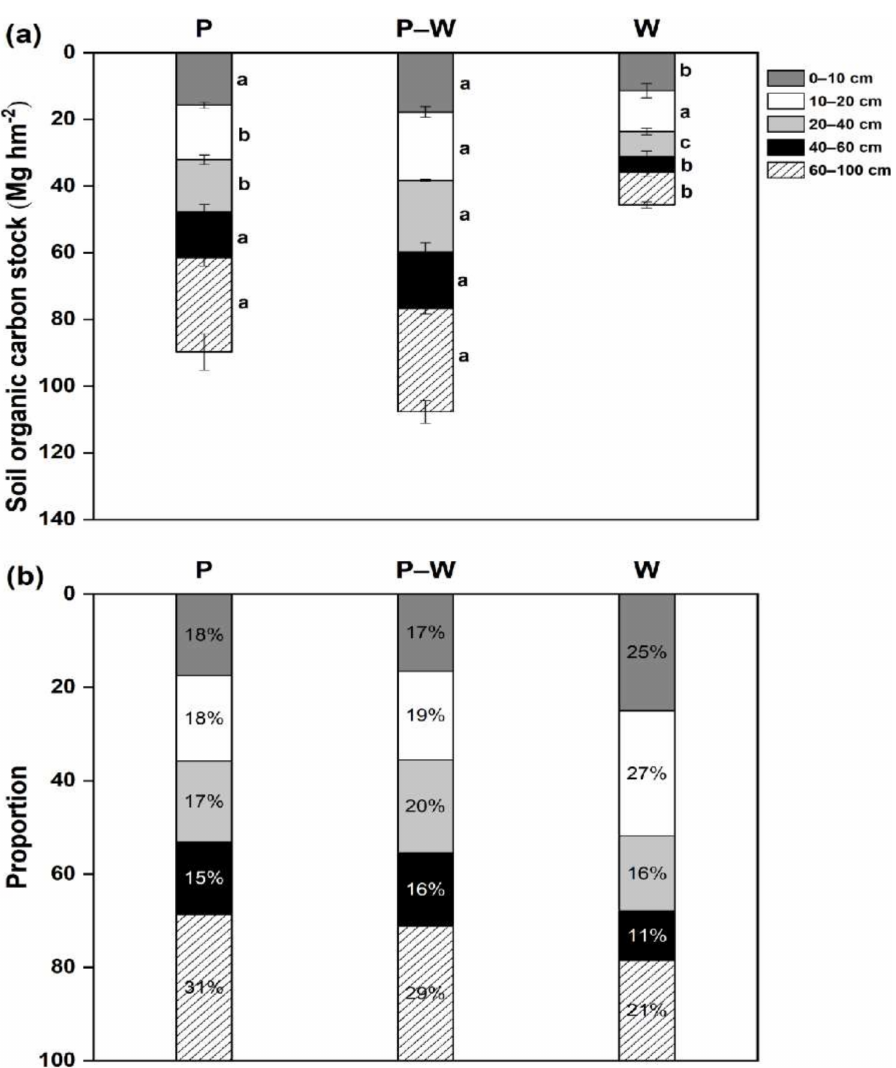
Figure 5. Vertical variation of SOC stocks in different land-use types ( a ) and the proportion in each soil layer in the different land-use types ( b ). The different lowercase letters indicate significant differences among planting systems for the same soil layer based on Duncan’s multiple comparison test at p < 0.05. P, poplar plantation system; P–W, wheat field system after deforestation of a poplar plantation; W, wheat field